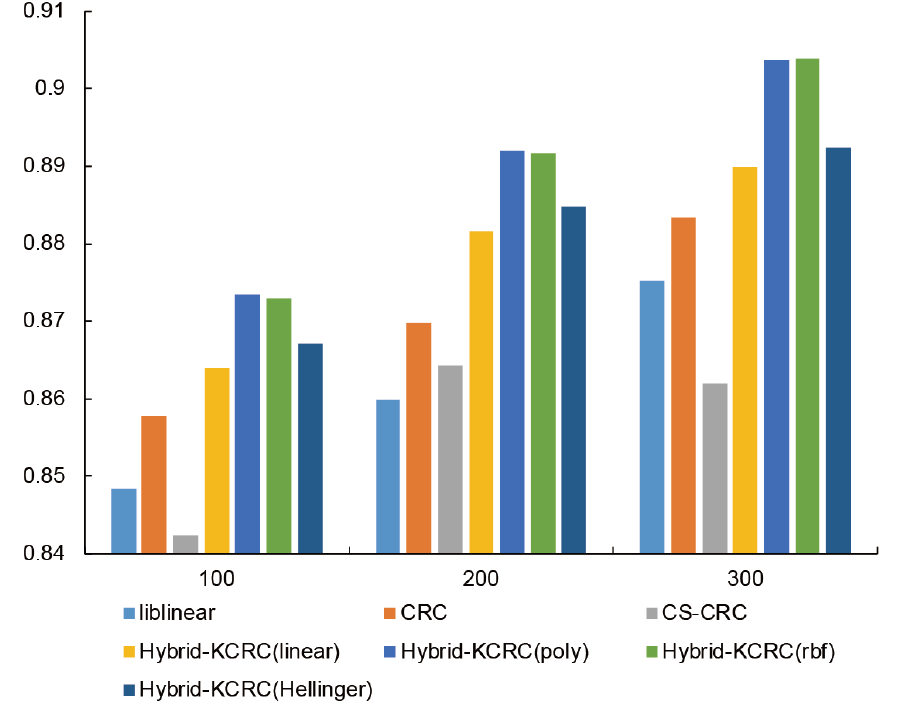
Figure 7. Classification rate on the RSSCN7 dataset with a different number of training samples in each